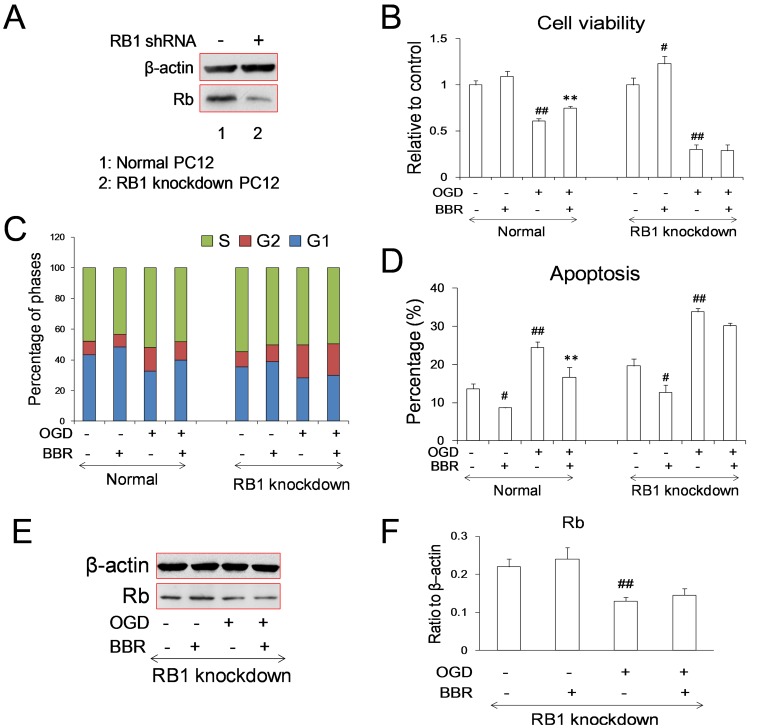
Effects of berberine (BBR) on the PC12 cells with RB1 knockdown.(A) Expression of Rb in normal and RB1 knockdown cells. RB1shRNA was constructed to lentiviral vector PLL3.7. (B) Cell viabilities of normal and RB1 knockdown cells. Columns represent the mean ± S.D. ## P<0.01 v.s. control groups; *P<0.05 v.s. model groups (n = 6). (C) Phases of cell cycle were detected in normal and RB1 knockdown cells. (D) Apoptosis of BBR after OGD treated cells using Annexin V-FITC double staining were detected by using flow cytometry. Data are presented as mean ± S.D. ## P<0.01 v.s. control groups; *P<0.05, **P<0.01 v.s. the OGD (n = 6). (E)–(F) Expression of Rb in cells infected with carrying RB1 shRNAlentivirus under normal and OGD conditions. BBR (0.5 µg/ml) was added in the culture 1 h before OGD treatment and throughout reperfusion. Data are presented as mean ± S.D. of three independent experiments (n = 3). ## P<0.01 v.s. the normal; **P<0.01 v.s. the OGD.